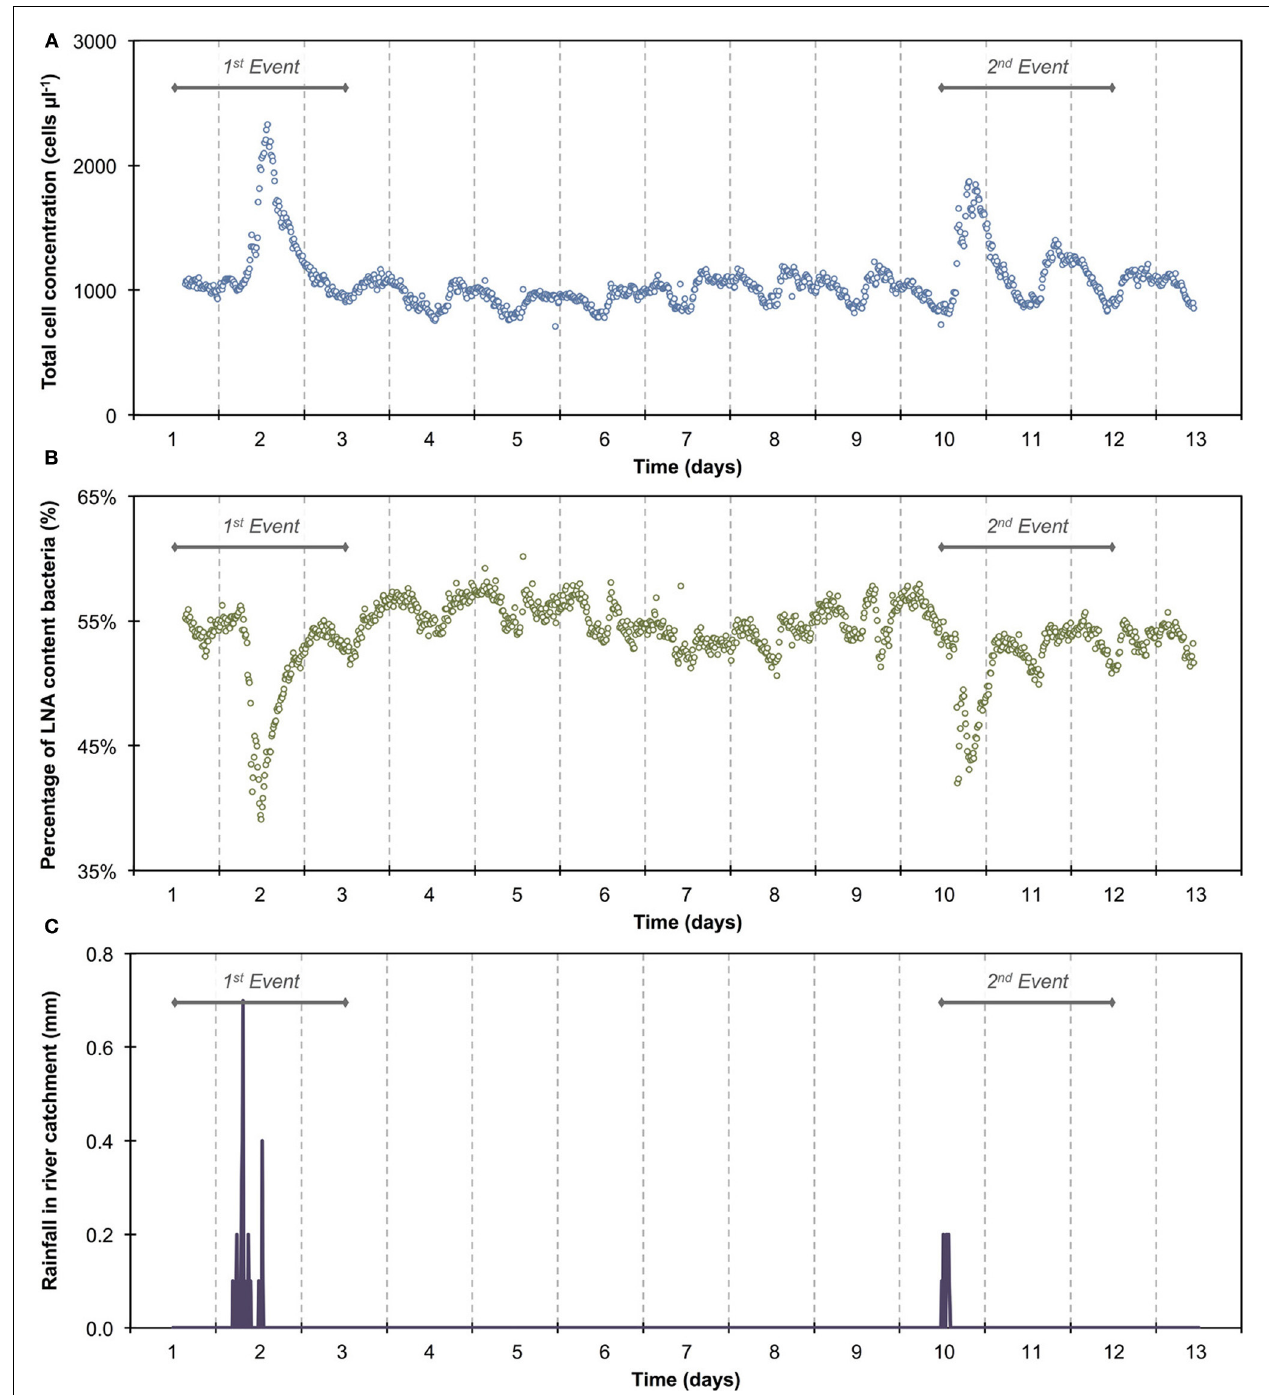
FIGURE 3 | Online FCM measurements of river water at 15-min intervals over 12 consecutive days, showing total cell concentrations (TCC) (A) and the percentage of LNA content bacteria (B) ( n = 1104). Two distinct events can be seen on days 1–3 and 10–12, corresponding directly